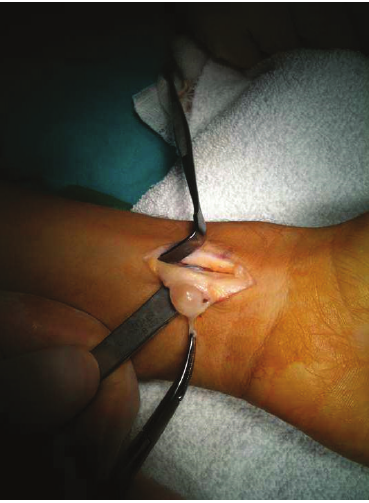
Figure 1: MRI revealed a 11 × 9mm mass located in flexor tendons which has intermediate signal on T1-weighted images and hyperintense signal on T2-fat weighted images.